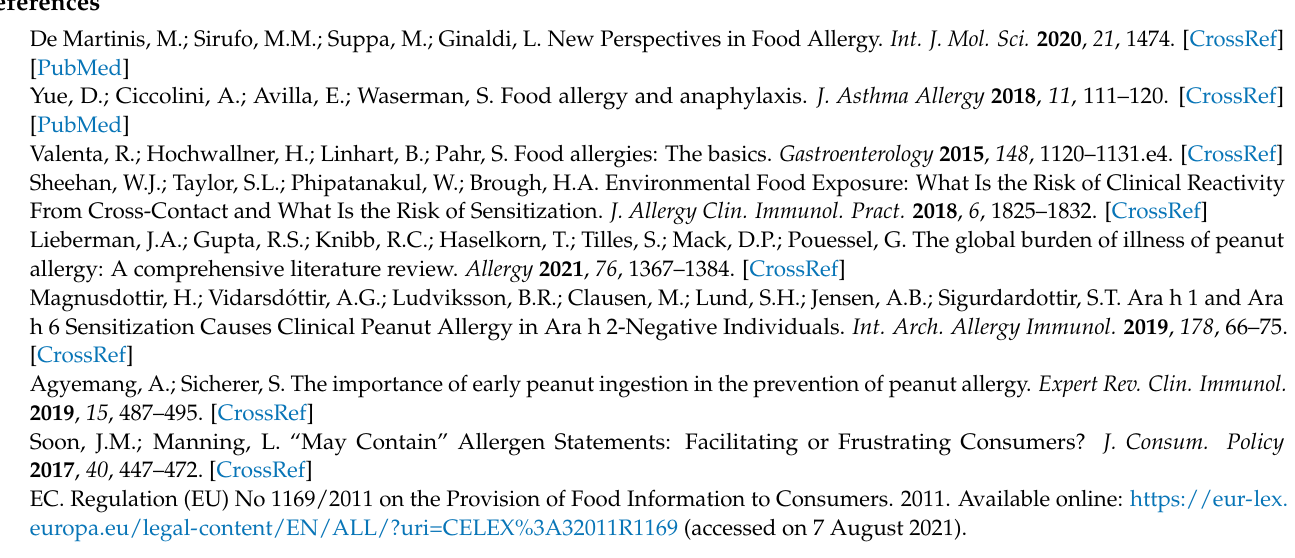
bination of steps; Table S2. Studied and selected variables for the analysis of Ara h 1; Table S3. Analytical characteristics of the developed electrochemical immunosensor for the analysis of Ara h 1; Table S4. Results of the recovery studies; Figure S1. Results from the interference (light grey bars, Ara h 1: 250 ng · mL − 1 ) and selectivity (dark grey bars) studies using non-target proteins: Ara h